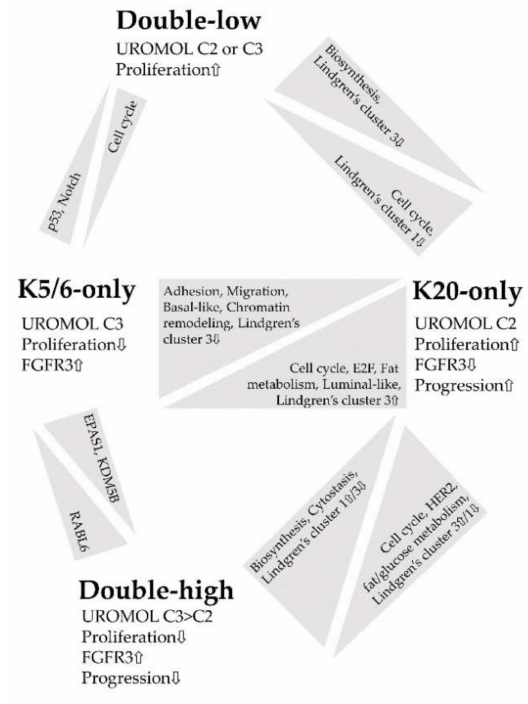
Figure 4. Summary of the functional enrichment of each comparison.